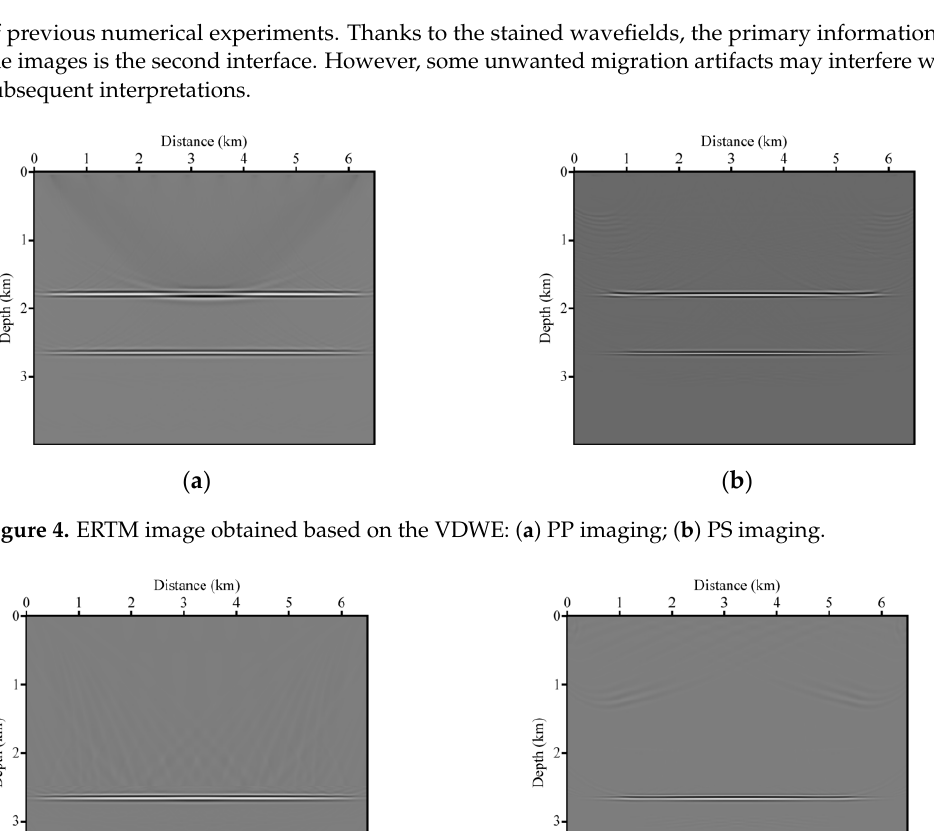
Figure 5. ERTM image based on the SVDWE: ( a ) PP imaging; ( b ) PS imaging.